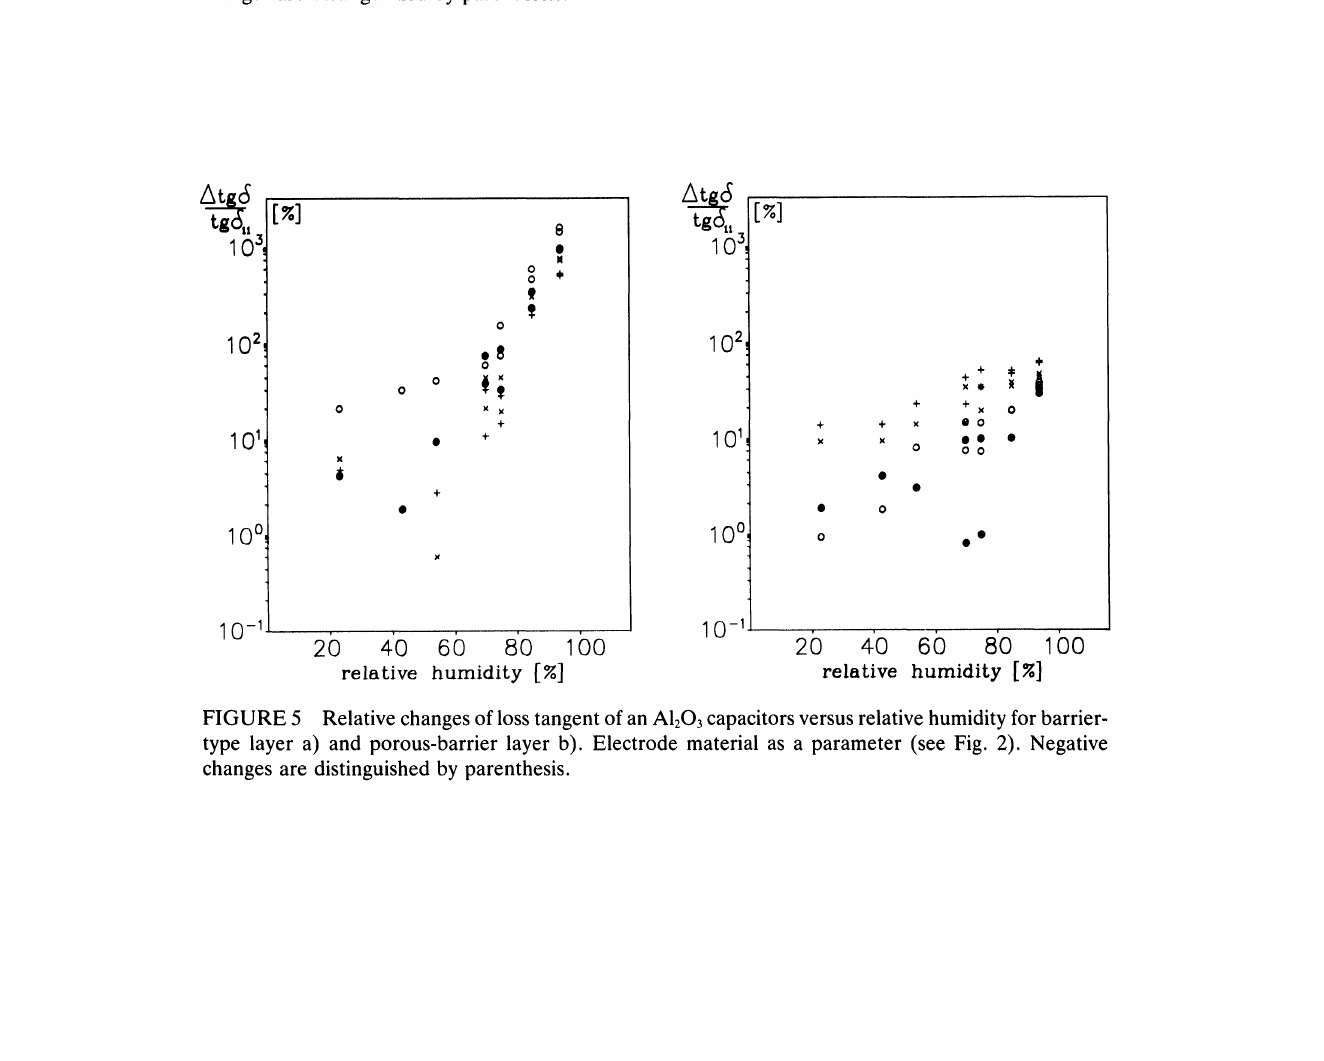
FIGURE 4 Relative changes of capacitance of an A1203 capacitors versus relative humidity for barrier- type layer a) and porous-barrier layer b). Electrode material as a parameter (see Fig. 2). Negative changes are distinguished by parenthesis.